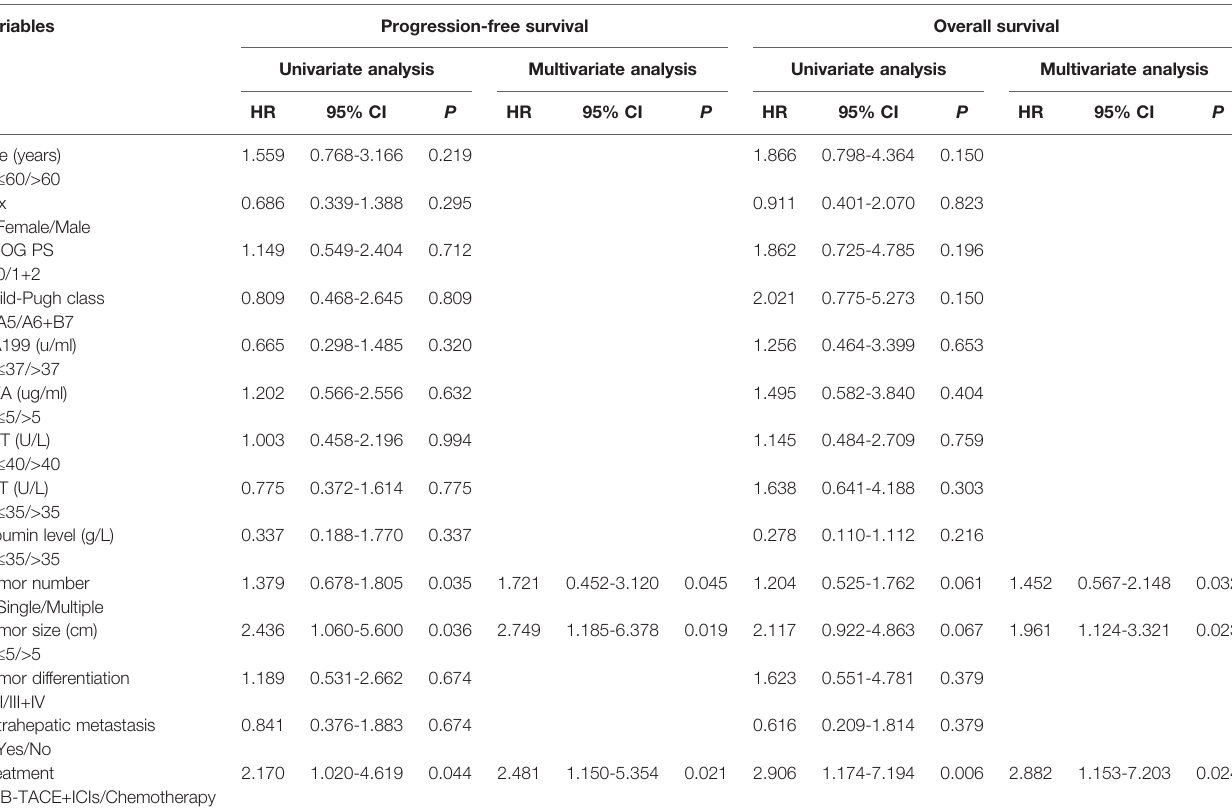
TABLE 3 | Prognostic factors associated with PFS and OS after PSM. Variables Progression-free survival Overall survival Univariate analysis Multivariate analysis Univariate analysis Multivariate